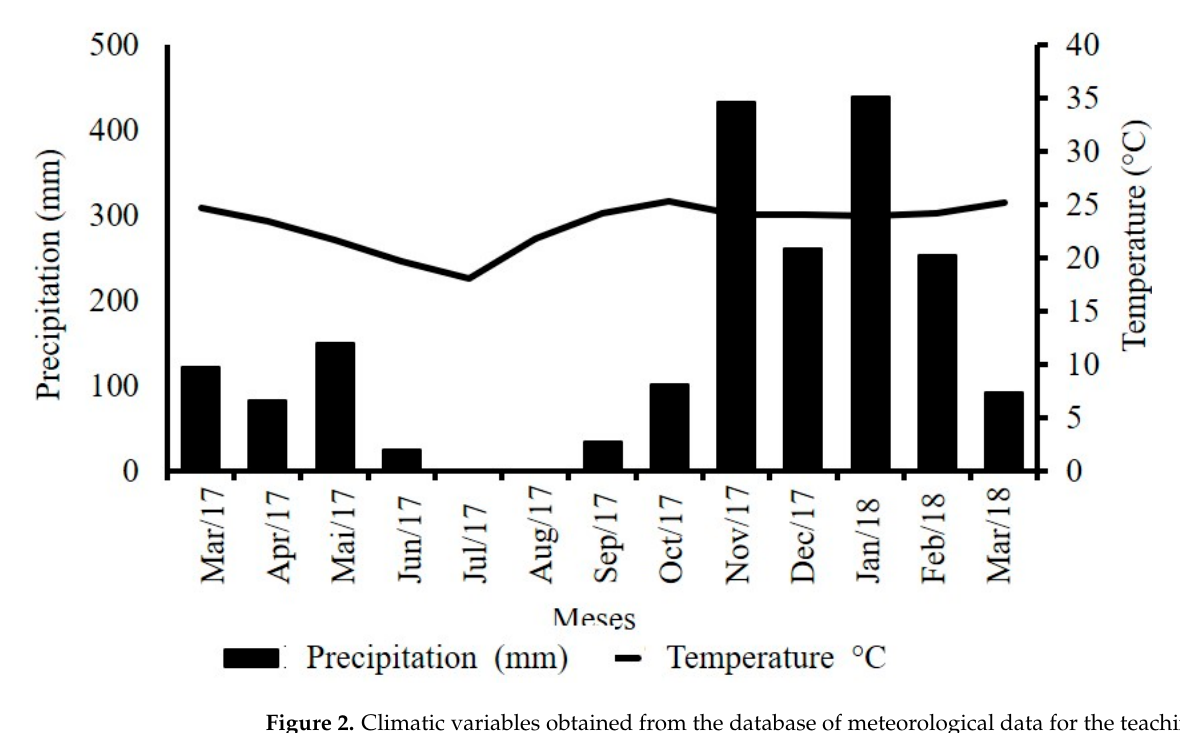
Figure 2. Climatic variables obtained from the database of meteorological data for the teaching and research of [30], for the period from March 2017 to March 2018. The soil of the areas was classified as Typic Hapludox [31] with sandy texture. The soil (0–40 cm) presented 220, 720, and 60 g kg − 1 of clay, sand, and silt, respectively, according to the soil chemical analysis (Table 2). Table 2. Soil chemical attributes in the 0–40 cm soil layer in different